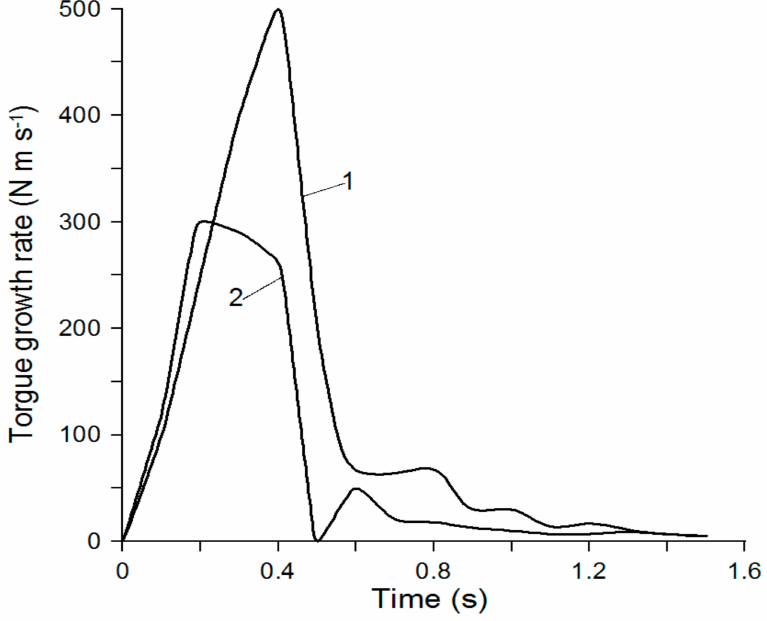
Figure 8. Speed change of torque M pto at the various operating modes of the tractor’s front PTO: 1–540 rpm; 2–1000 rpm.